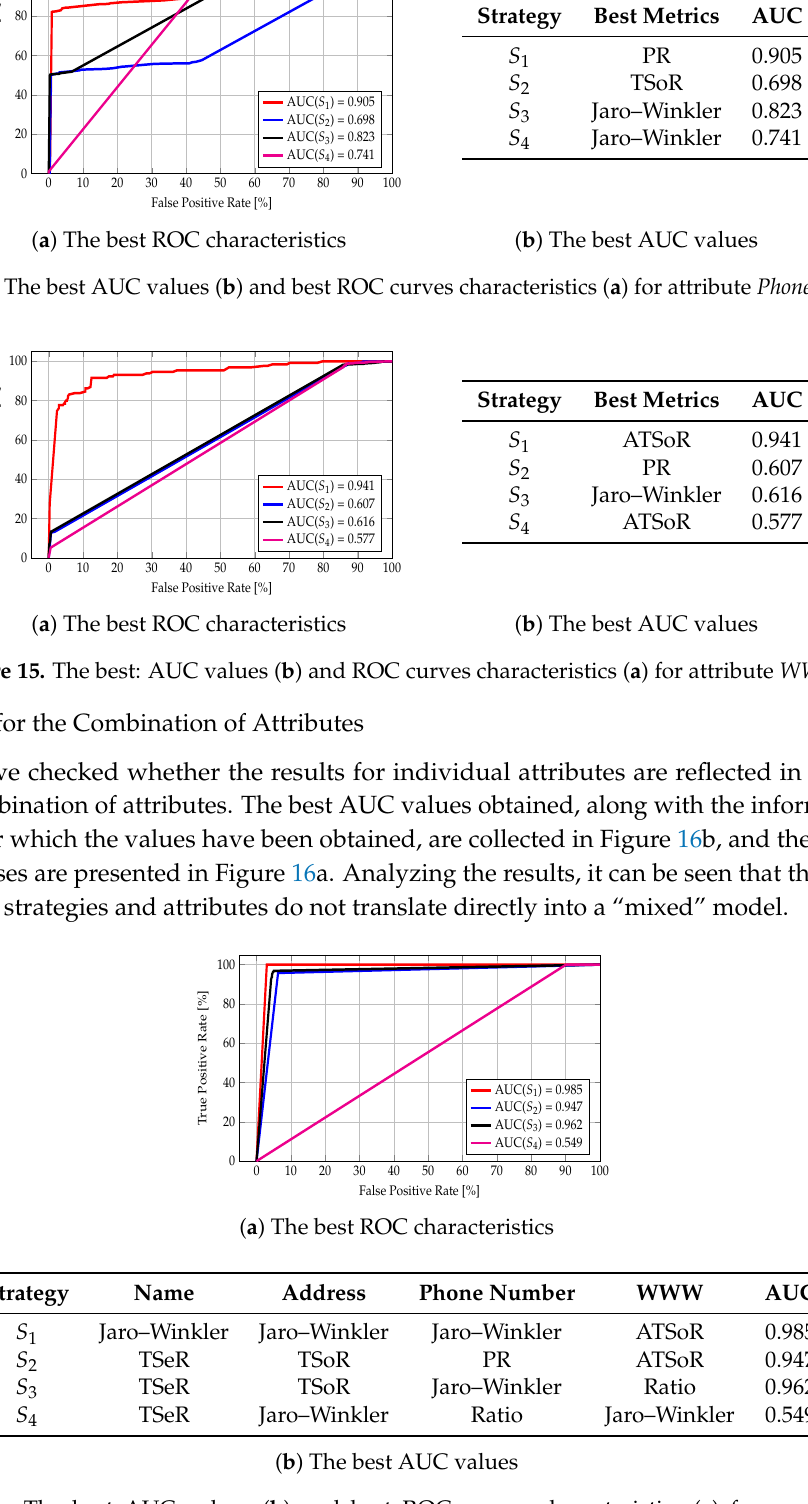
Figure 16. The best AUC values ( b ) and best ROC curves characteristics ( a ) for combination of